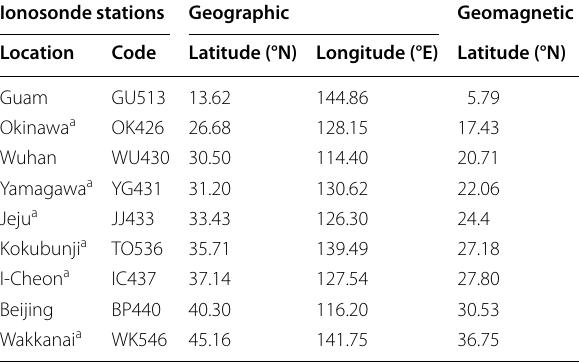
The arrangement is in ascending geomagnetic latitude a Indicates stations located within the sub-grid region of high-resolution marked out in blue dash lines in Fig.